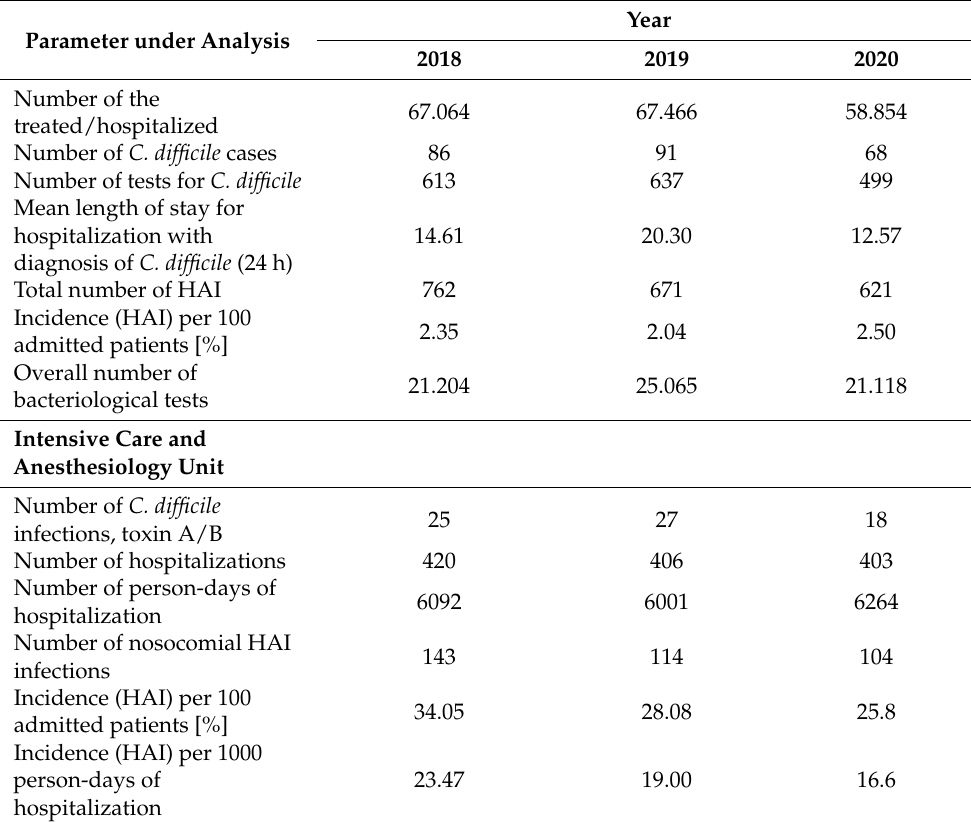
Table 6. Characteristics of the hospital and of the Intensive Care and Anesthesiology Unit (ICAU)